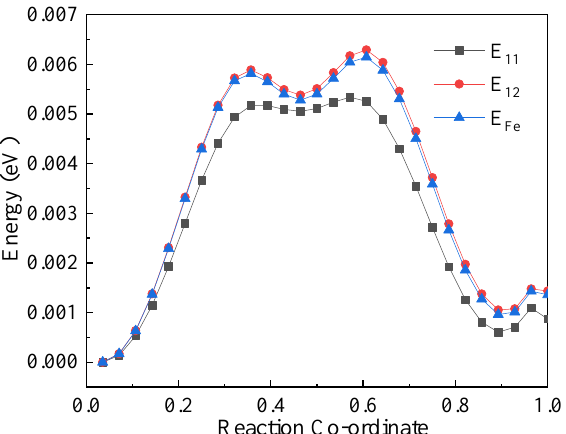
Figure 3. Migration energy barriers required for the vacancy to migrate along different paths. E 11 represents the migration energy required for the exchange of positions between the Cu atoms and the vacancy; E 12 represents the migration energy required for the vacancy to migrate from the first neighbor of the Cu atoms to the second neighbor of Cu atoms; E Fe means the migration energy required for the position exchange between vacancy and Fe